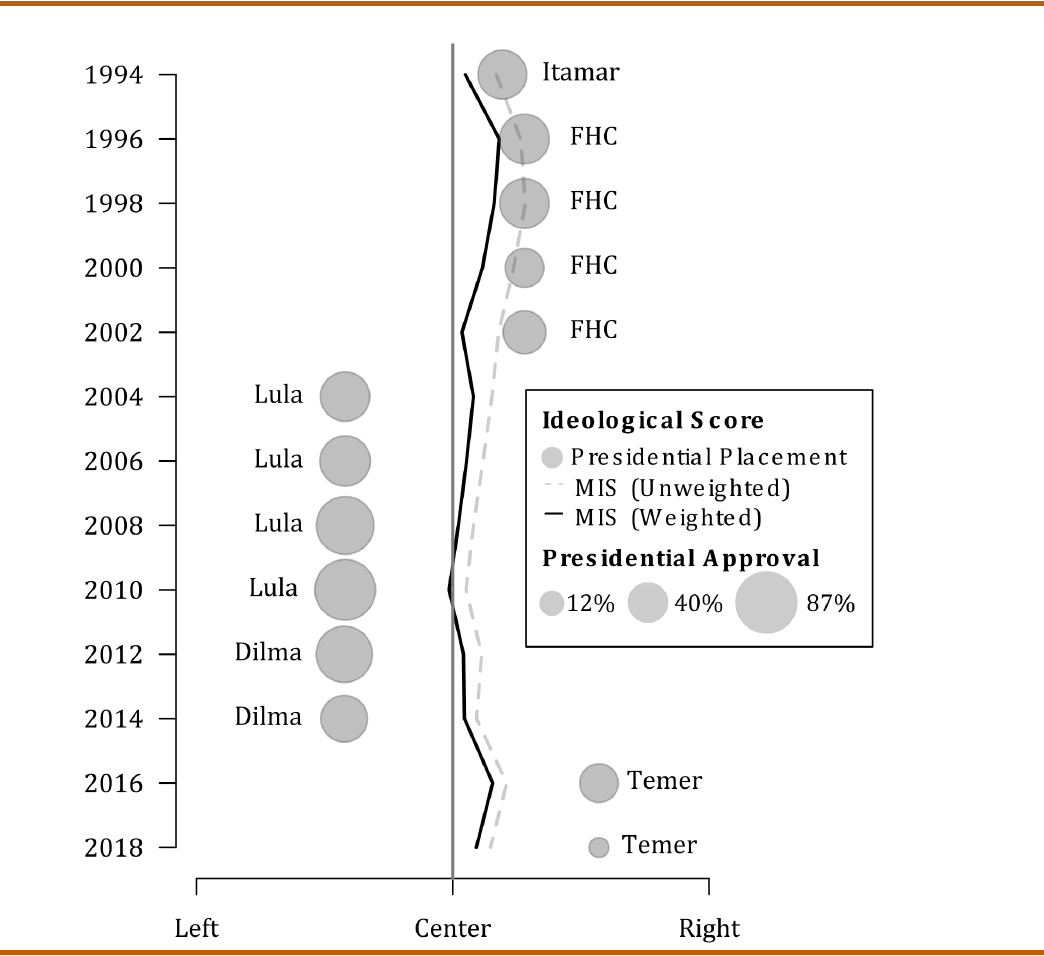
Figure 4: Presidential Ideology, Approval, and Municipal